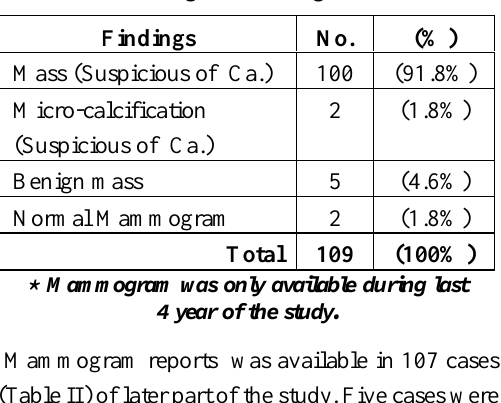
Table II. Mammogram findings (no=109 cases)